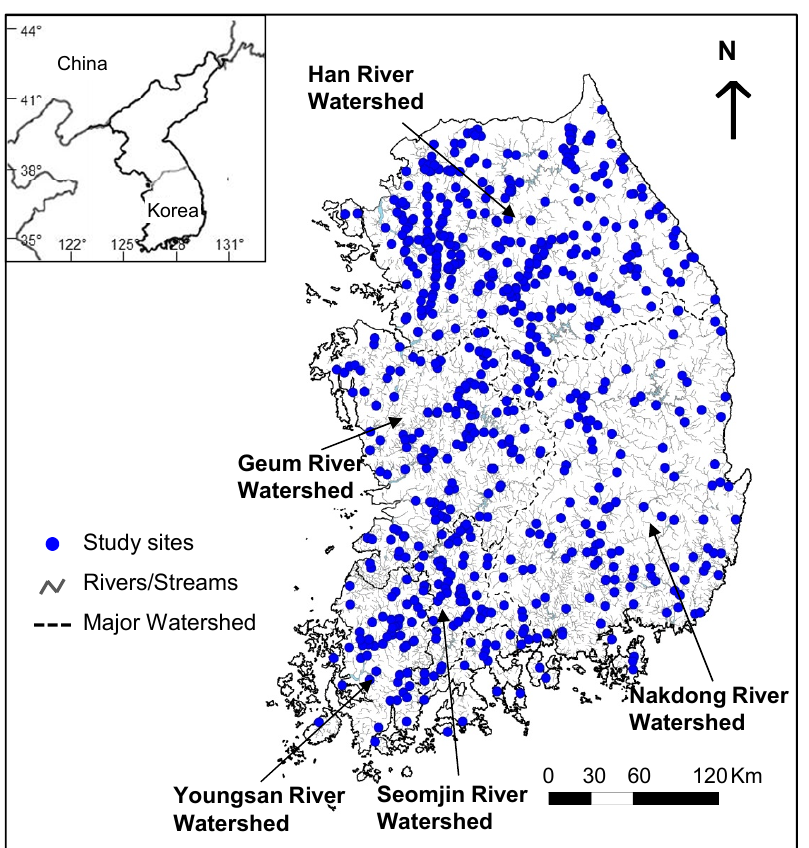
Figure 1. Locations of the sampling sites in five major watersheds in South